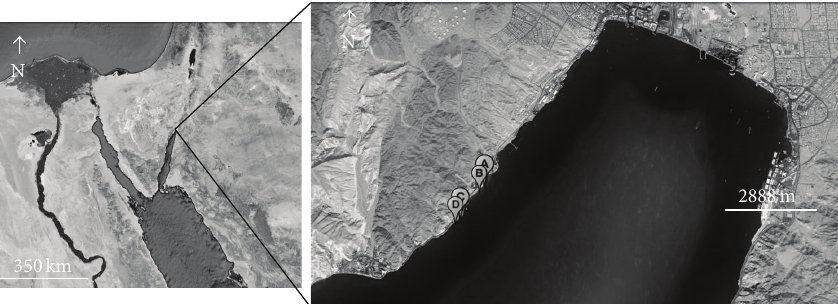
Figure 1: Study area south of Eilat, Israel (29 ∘ 33 󸀠 00N 34 ∘ 57 󸀠 14E). Survey sites are (A) coral beach, (B) Japanese gardens, (C) Interuniversity Institute, and (D)